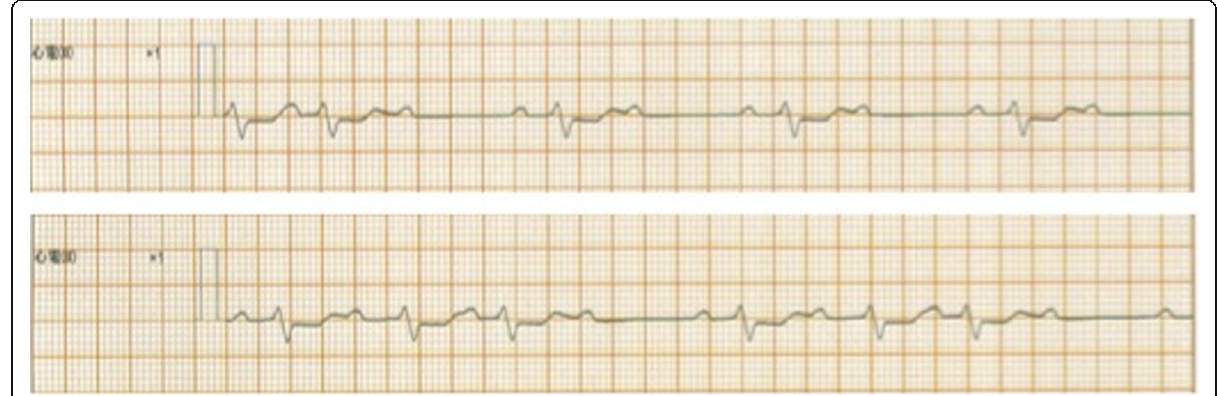
Fig. 3 Electrocardiogram strips on the next morning. Complete atrioventricular block was seen